Question: What form of chart is displayed?
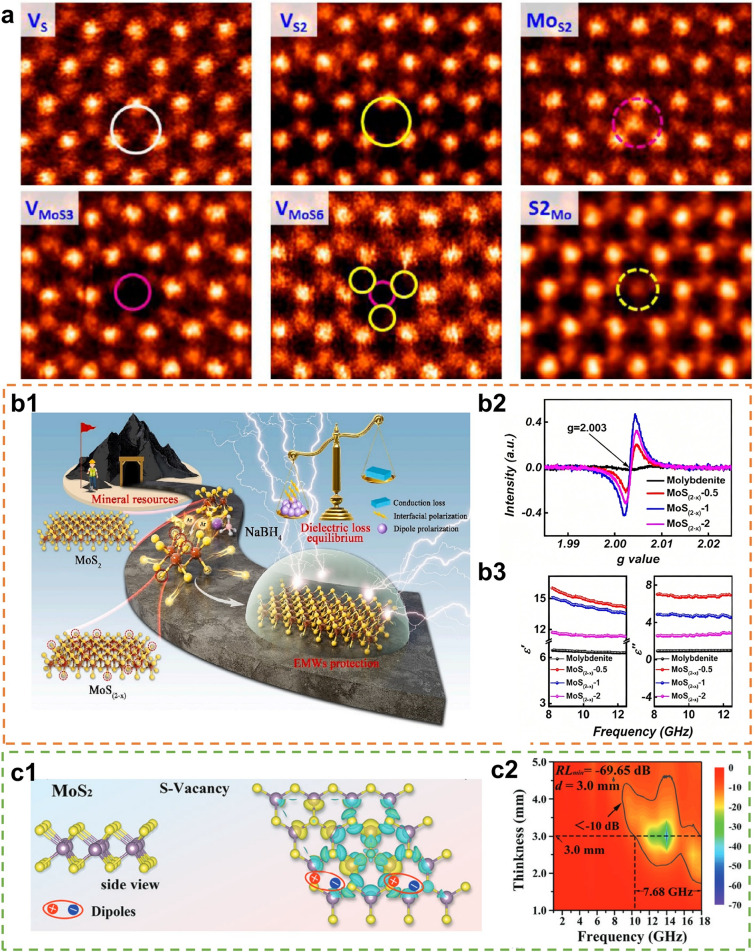
Answer: line